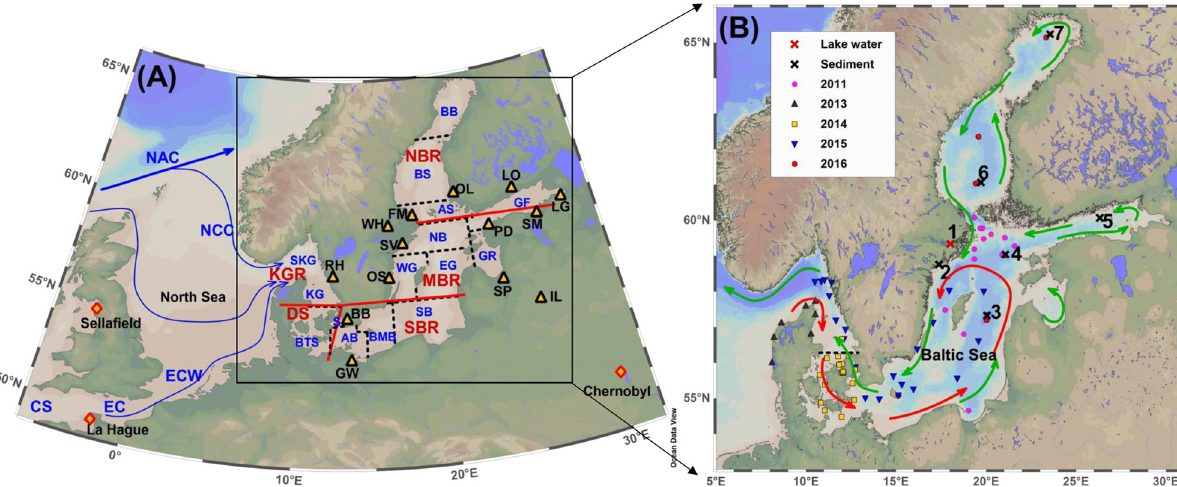
Fig. 1 Study region and sampling map. Overview of schematic circulation water mass in North Sea-Baltic Sea region ( A ) and sampling stations in this work as well as nuclear installations around the Baltic Sea ( B ). The symbols in A are CS Celtic Sea, EC English Channel, ECW English Channel Waters, NAC North Atlantic Current, NCC Norwegian Coastal Current, BB Bothnian Bay, BS Bothnian Sea, AS Archipelago and Åland Sea, GF Gulf of Finland, NB Northern Baltic Proper, WG Western Gotland Basin, EG Eastern Gotland Basin, GR Gulf of Riga, SB Sourth Baltic Proper, BMB Bornholm Basin, AB Arkona Basin, S The Sound, BTS Belt Sea, KG Kattegat, SKG Skagerrak, KGR Kattegat – Skagerrak region including the Kattegat, Skagerrak and Danish west coast nearby the North Sea, DS Danish Straits including the Belt Seas and the Sound, SBR South Baltic Sea region including Arkona Basin, Borholm Basin, and South Baltic Proper, MBR Middle Baltic Sea region including Northern Baltic Proper, Western Gotland Basin, Eastern Gotland Basin and Gulf of Riga, and NBR North Baltic Sea region including Archipelago and Åland Sea, Bothnian Sea and Bothnian Bay) Nuclear installations including: RH Ringhals NPP, BB Barseback NPP, GW Greifswald NPP, OS Oskarshamn NPP, SV Studsvik AB site, WH Westinghouse Electric Sweden AB, FM Forsmark NPP, OL Olkiluoto NPP, LO Loviisa NPP, LG Leningrad NPP, IL Ignalina NPP, SM Sillamäe site, PD Paldiski site, SP Salaspils research reactor. The stations marked with cross in B are either lake water or sediment samples (1 — Lake Mälaren water; 2 — Studsvik sediment; 3 — sediment BY15; 4 — sediment LL17; 5 — sediment LL3a; 6 — sediment EB1; 7 — sediment CVI), all the other samples are seawaters collected in different years during 2011 – 2016 as marked with different symbols. Red arrows refer to bottom water movement and green arrows refer to surface water